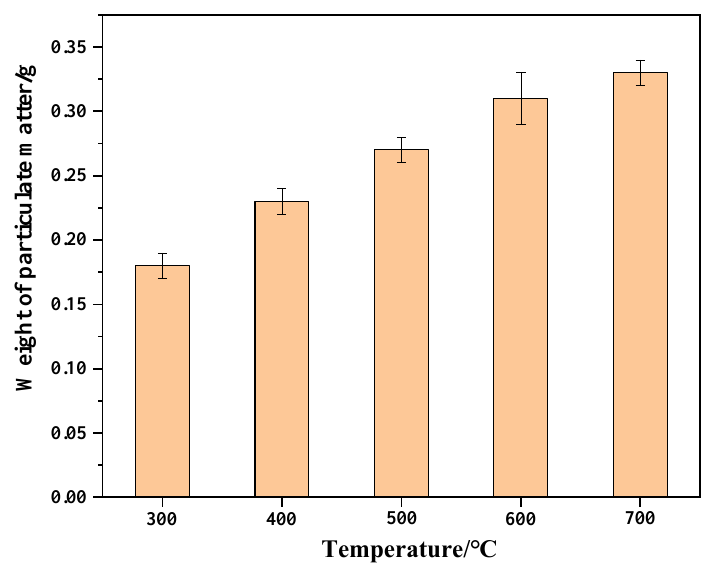
Figure 3. Mass of PM at different pyrolysis temperatures.